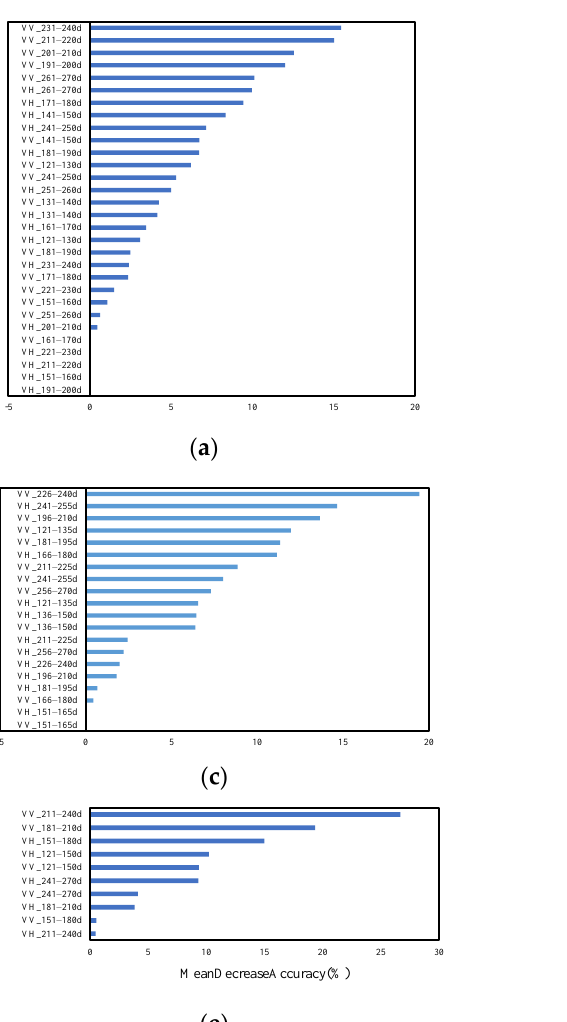
Figure 10. Importance assessment of crop classification features in 2018 and 2019 of Keshan farm with different time in- terval composite images (( a ) MeanDecreaseAccuracy_2018_10d; ( b ) MeanDecreaseAccuracy_2019_10d; ( c ) Mean- DecreaseAccuracy_2018_15d; ( d ) MeanDecreaseAccuracy_2019_15d; ( e ) MeanDecreaseAccuracy_2018_30d; ( f ) Mean- DecreaseAccuracy_2019_30d).